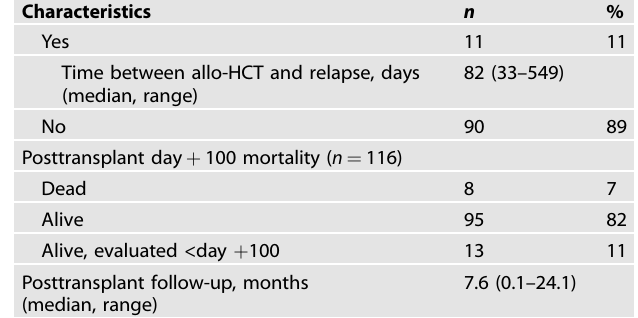
Table 4. Transplant characteristics, toxicity and